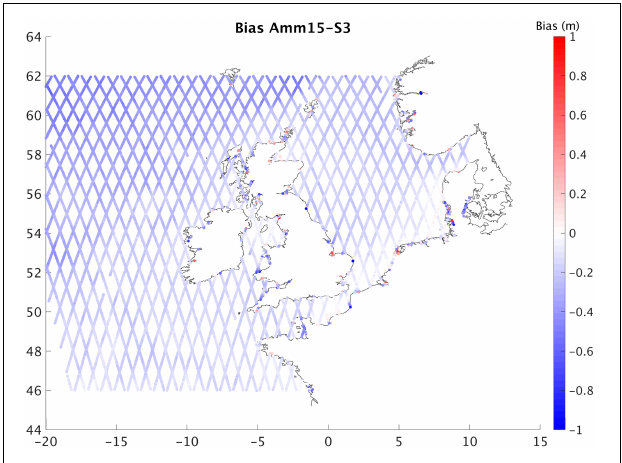
FIGURE 7 | Mean bias between model and satellite observations along repeating tracks between June 2016 and December